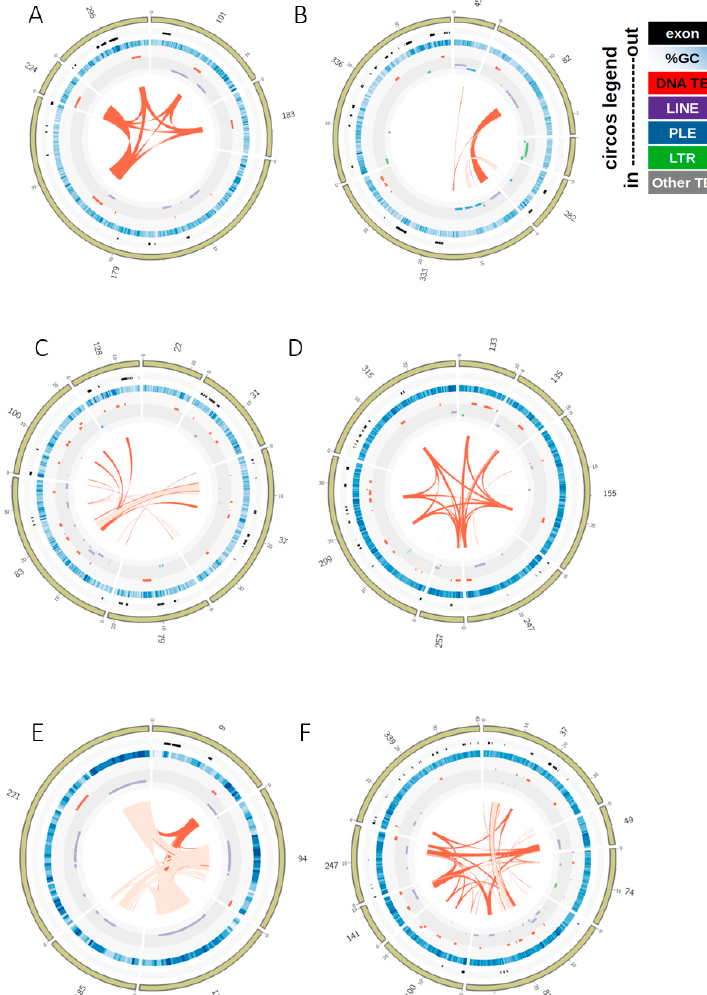
Figure 5. Sequence features of representative fosmid contigs. Features of contigs (marked outside in yellow) are plotted on tracks and their identities indicated as colored boxes shown in the figure legend. Shades of red inside the circles represent % identity from BLAST searches (dark color 100%, intermediate 90–99%, and light color 80–89%), indicating recent transposition (see also Table S4). Large numbers on the outside indicate contigs; smaller numbers, the position in kb. Translated TEs were identified with Censor; transcripts, exons and introns were predicted with Augustus; all features visualized with Circos. For further details on contigs, see Table S3A. ( A ) Contigs Ds_ctg224, Ds_ctg295, Ds_ctg101, Ds_ctg183 and Ds_ctg179 containing mariner-1 DNA TEs. ( B )